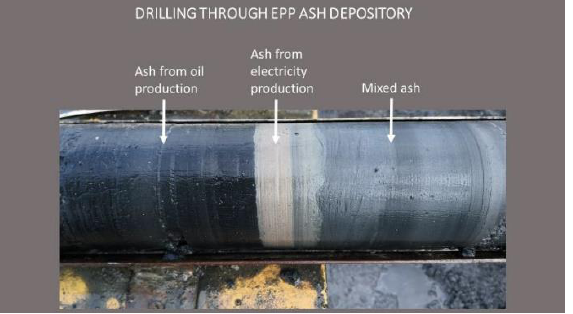
Figure 1. Drill core from ash disposal site at the Eesti Power Plant, north-eastern Estonia.